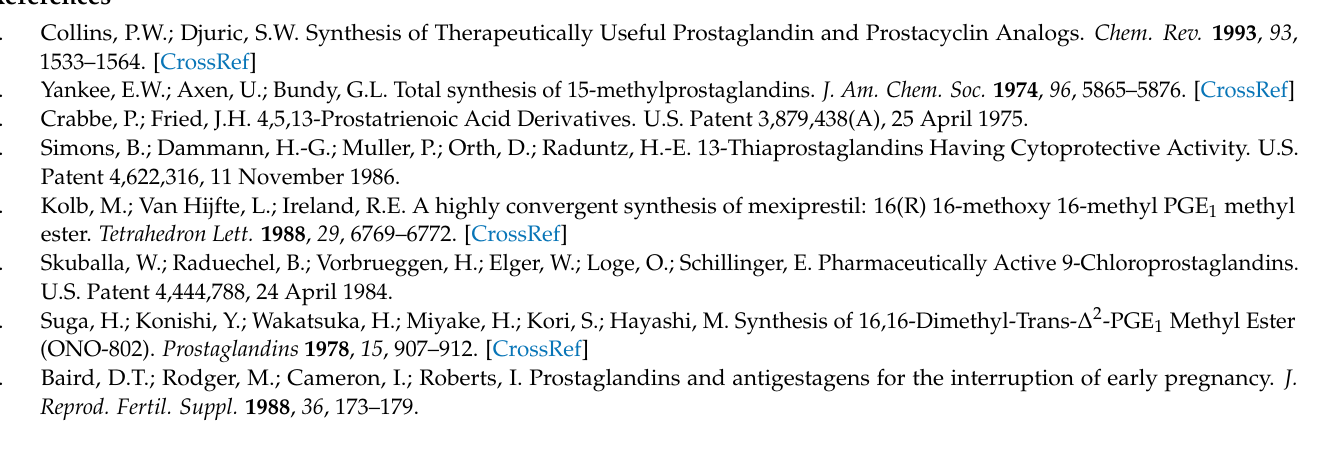
6b ; Table S3: Angles between atoms ( ◦ ) for compounds 6c and 6b , Crystal structure determination of compound 6b from powder diffraction data and Figure